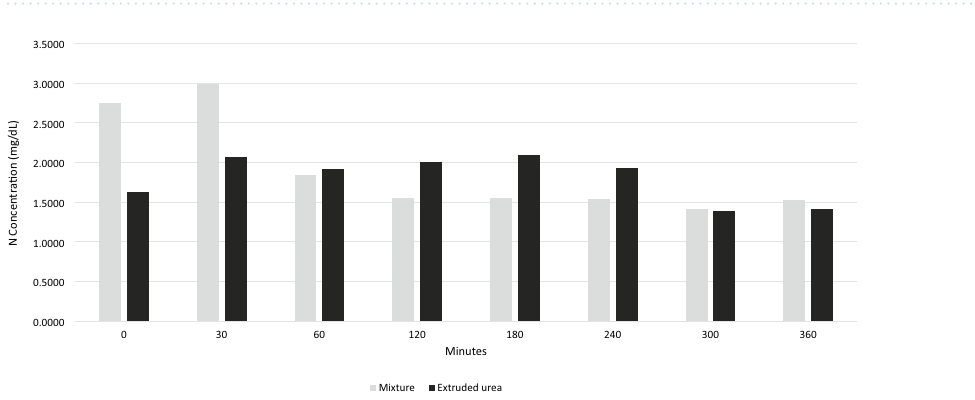
Figure 2. Nitrogen solubility (mg/dL) in water as a function of in vitro incubation time at 39